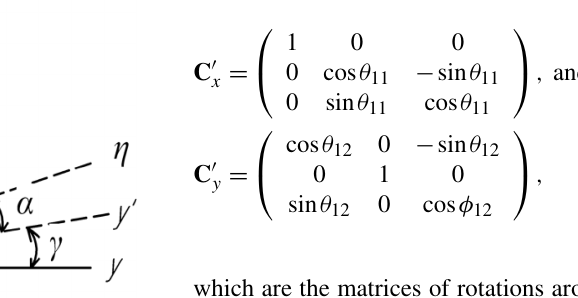
which are the matrices of rotations around the x and y axes by the angles θ 11 and θ 12 , respectively. θ 11 and θ 12 are the angles between the adjacent pairs.